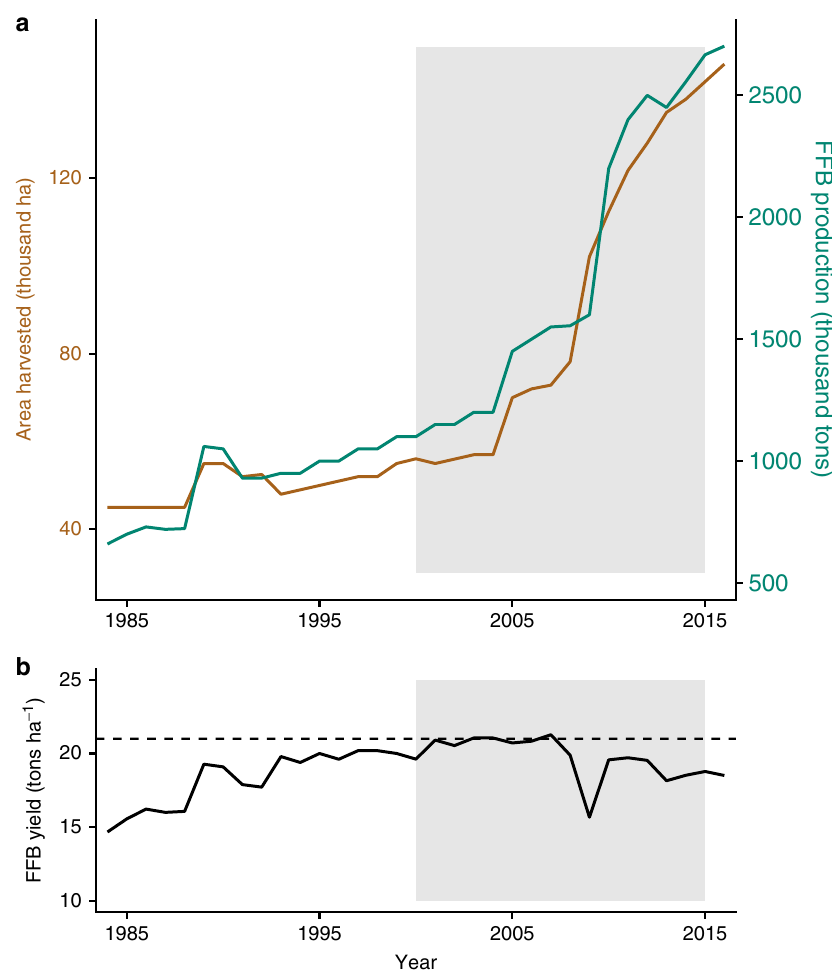
Fig. 1 Oil palm area expansion (extensi fi cation) in Cameroon. a Oil palm production (green) and area harvested (orange) since 1985 for the country of Cameroon, with the time-period considered in this study (2000 – 2015) highlighted in gray 6 . b On-farm fresh fruit bunch (FFB) yield in Cameroon since 1985. For comparison, the horizontal dotted line represents the FFB yield in Indonesia 54 . Note: yield values from FAOSTAT 6 reported in b should be viewed with caution, as it is dif fi cult to obtain quality data on yield, especially from smallholder farmers. FAOSTAT yield values are much higher than yields observed in the fi eld